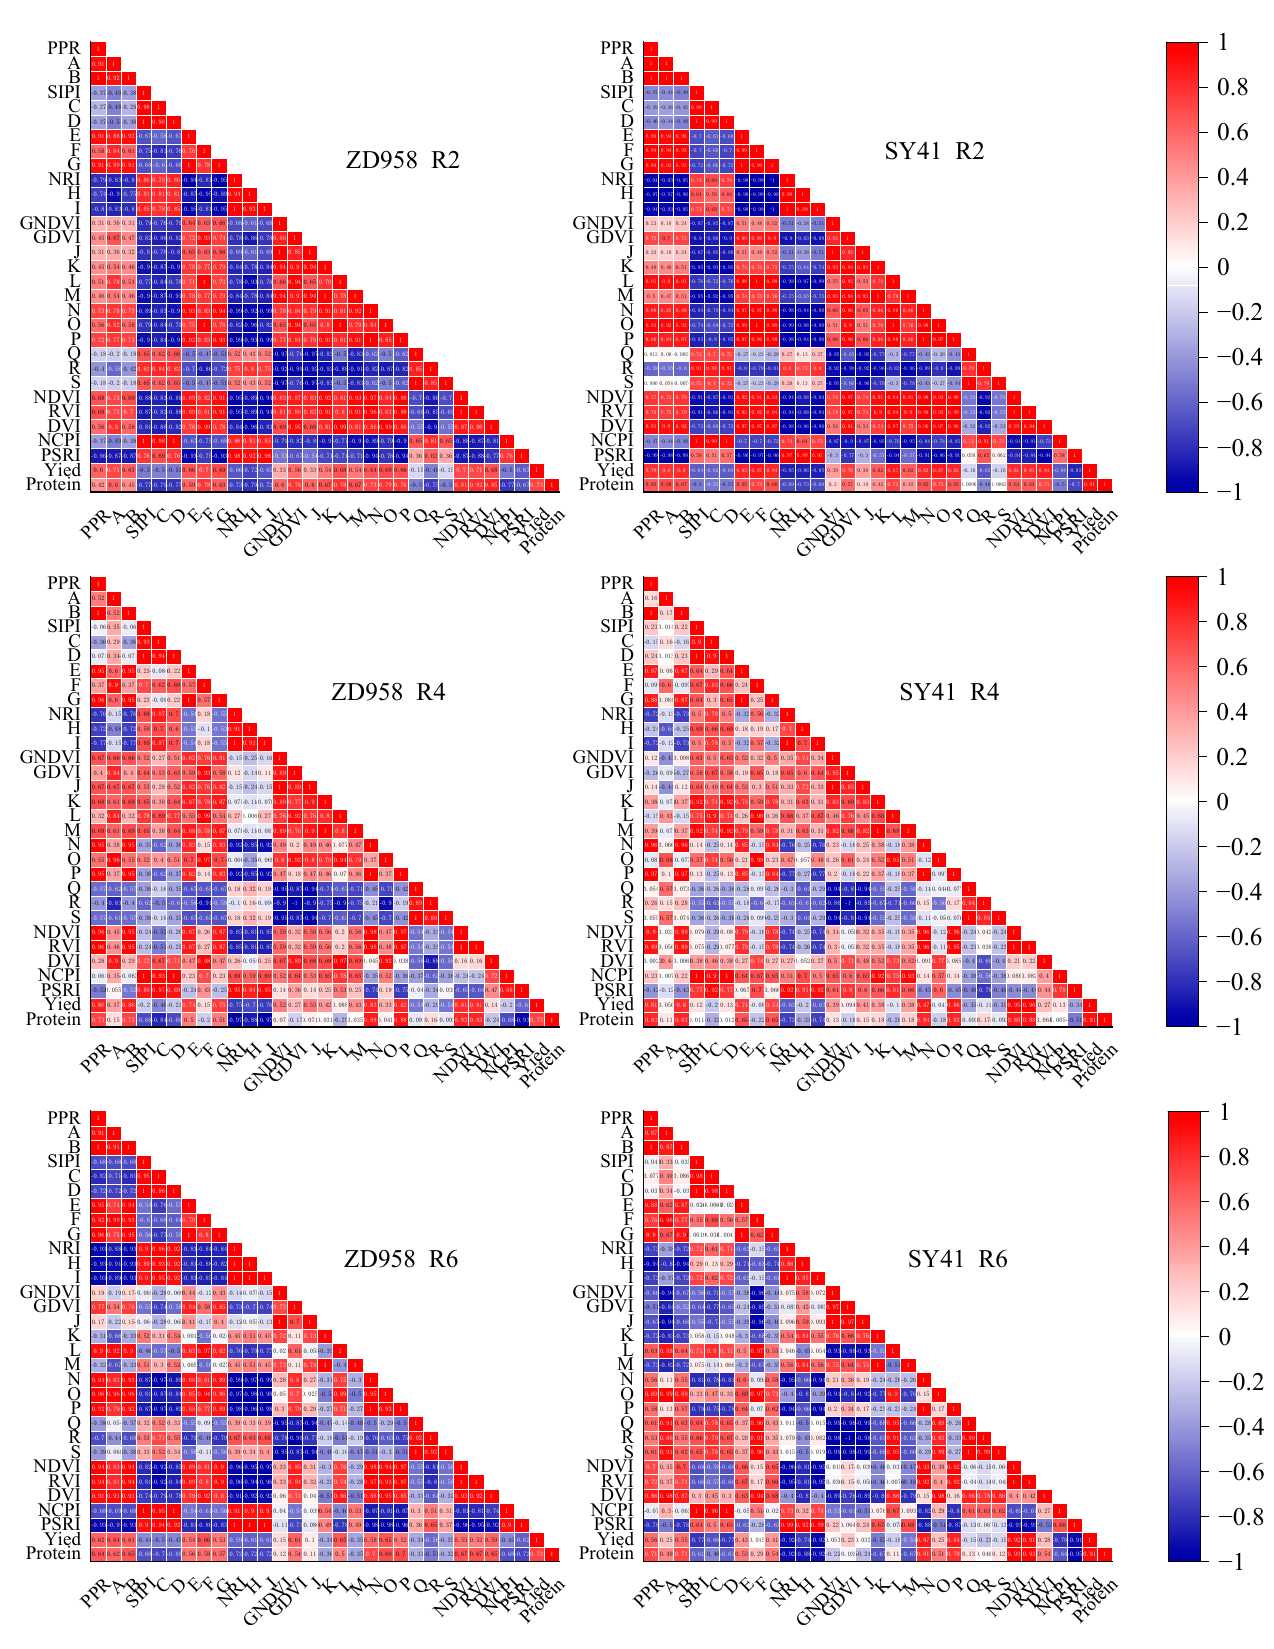
Figure 3. The correlation matrix between all parameters at different growth stages in 2020.